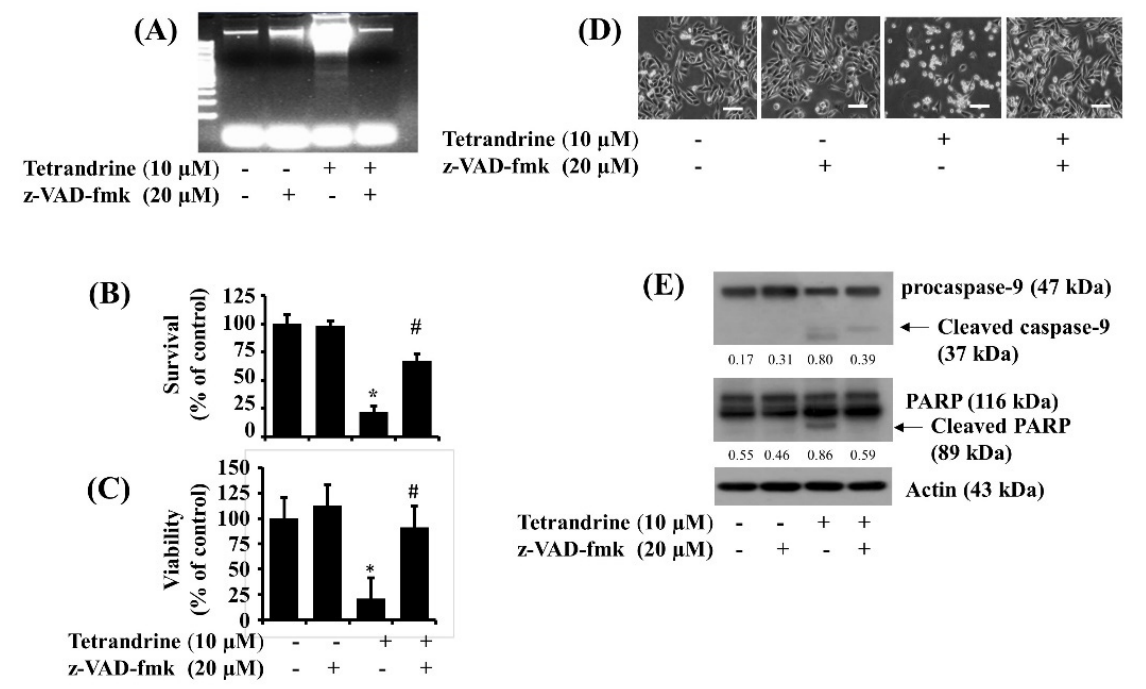
Figure 3. Effects of z-VAD-fmk on the tetrandrine-induced apoptosis, growth suppression, and altered expression of procaspase-9 and PARP in SW872 cells. ( A – E ) SW872 cells were pre-treated with 20 µ M z-VAD-fmk for 1 h and then treated with vehicle control (0.1% DMSO) or tetrandrine at 10 µ M for an additional 24 h. Genomic DNA from the conditioned cells was extracted and visualized by 1.8% agarose gel electrophoresis ( A ). The number of surviving cells was determined by cell count assay ( B ). Data are mean ± SE of three independent experiments. The cell survival was normalized as a percentage of control value without any drug. * p < 0.05 compared to the control value at the indicated concentration. # p < 0.05 compared to the value obtained from tetrandrine treatment in the absence of z-VAD-fmk. The viability of cells was analyzed by the MTS assay ( C ). The MTS assay was carried out in triplicate. Data are expressed as mean ± SE of three individual experiments. * p < 0.05 compared to the control value at the indicated concentration. # p < 0.05 compared to the value obtained from tetrandrine treatment in the absence of z-VAD-fmk. The morphological image of the conditioned cells was captured by a phase-contrast microscope (400×, scale bar = 50 μ m). Each image is the representative of three independent experiments ( D ). Whole-cell lysates from the conditioned cells were prepared and analyzed by Western blotting ( E ) to measure the expression of procaspase- 9, PARP, or β -actin. The image is the representation of three independent experiments.